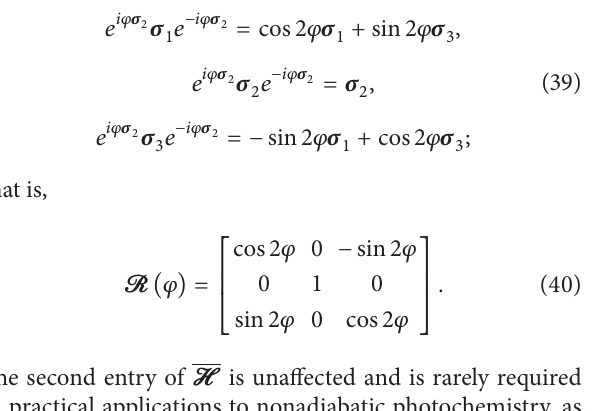
Table 1: Multiplication table of Pauli matrices (left times top).